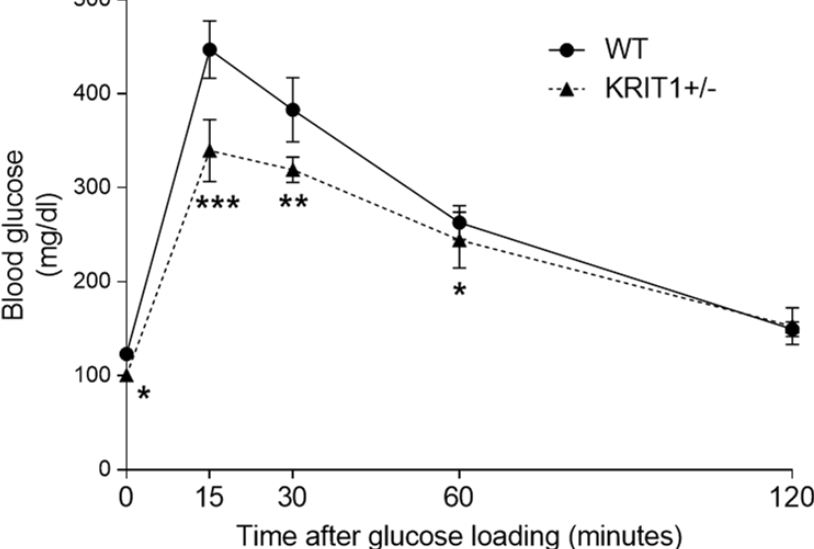
Figure 1. Glycemia monitoring during oral glucose tolerance test (OGTT). OGTT was performed in 26-week-old heterozygous KRIT1 knockout (KRIT1 +/− ) mice and wild-type (WT) littermate controls after a fasting period of 18 h by administering a glucose solution (2 g/kg) orally via gavage. Plasma glucose levels were measured with a glucometer before glucose administration (time zero)